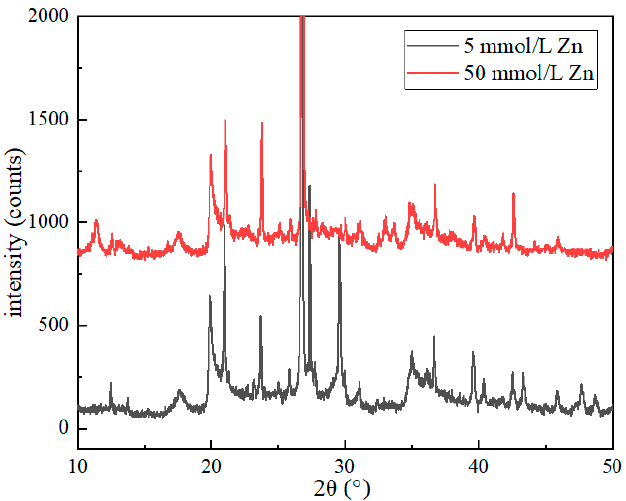
Figure 11. Relationship between initial concentration of pollutants and XRD patterns (25 ◦ C).